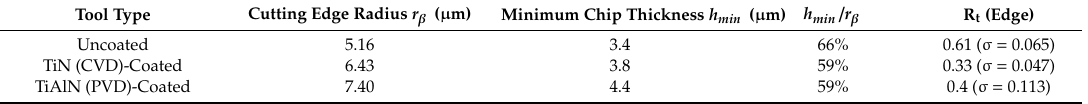
Table 4. Cutting edge radii and inversely determined h min values for three tool types.